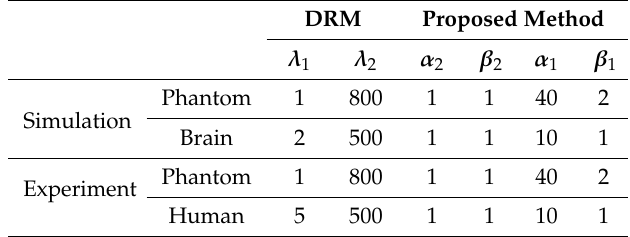
Table 1. Parameters of the double regularization method (DRM) and the proposed